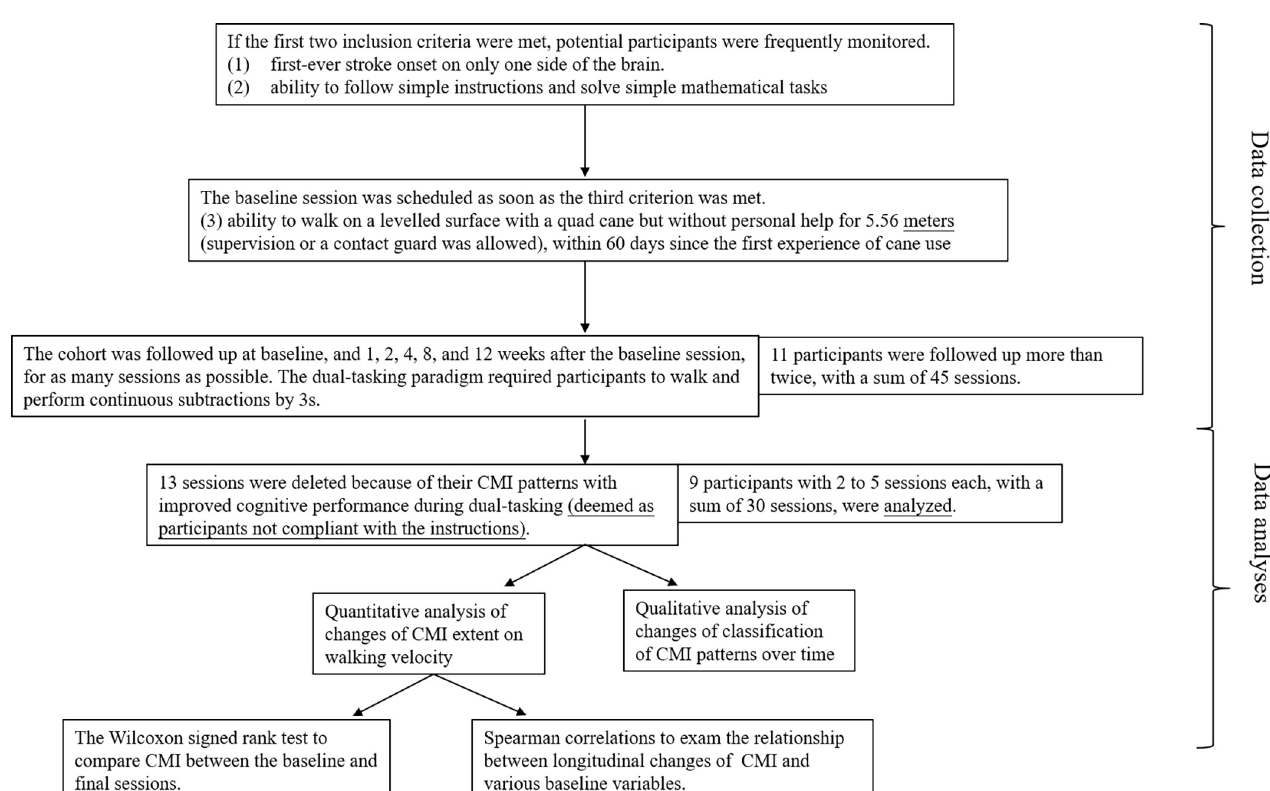
Fig 1. Flowchart of data collection and data analyses. CMI is the abbreviation of cognitive-motor interference.